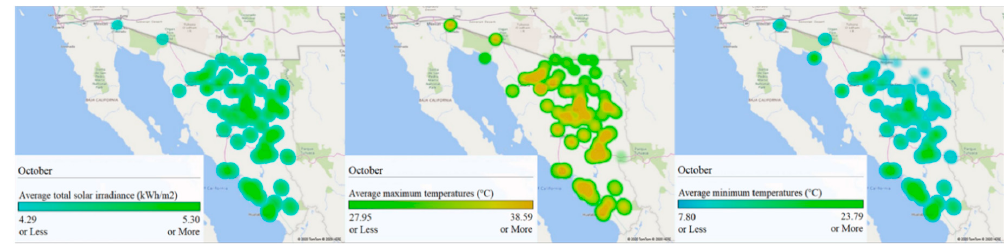
Figure 16. GIS analysis of Sonora for October: ( left ) average total solar irradiance (kWh/m 2 ), ( center )